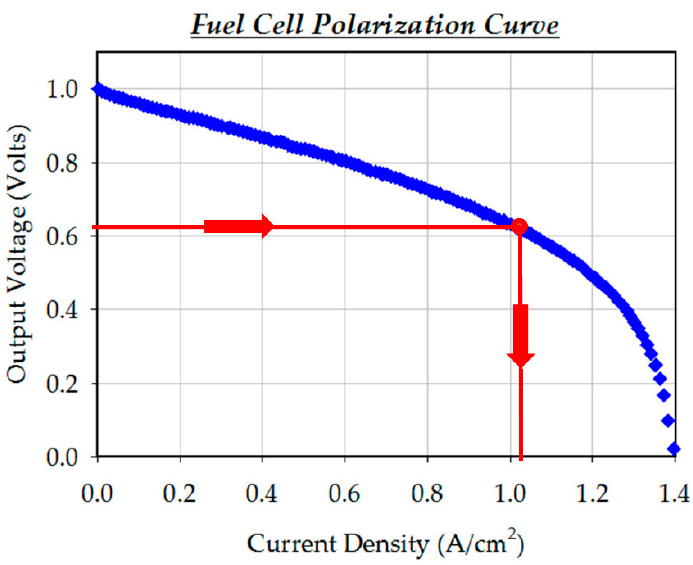
Figure 3. PEM fuel cell polarization curve (selected voltage corresponded to the current at peak power).